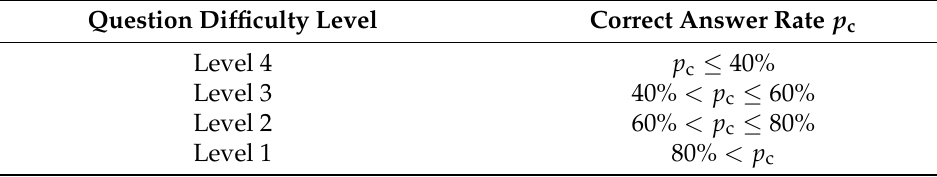
Table 2. Question Difficulty.